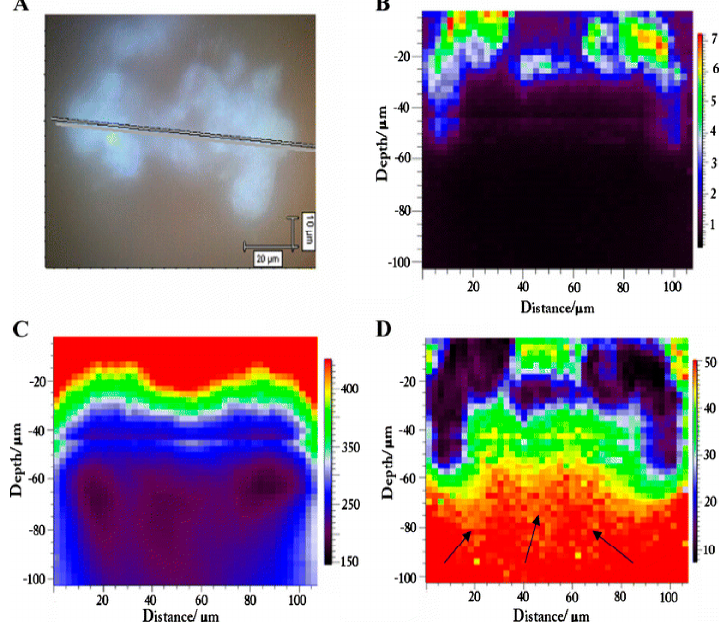
Figure 1. Colony in a pure small colony variant (SCV) PAO1 biofilm 21 days after inoculation, showing cavities filled with water and little biomass in the core of the colony. ( a ) Bright field image. Raman spectra (1084 cm − 1 ) were collected every 2.5 μ m in a plane extending down from the line shown through the colony in a. ( b ) Map of CH 3 signal (3300–3500 cm − 1 , biomass). ( c ) Map of OH signal (2905–2965 cm − 1 , water). ( d ) Map of water to biomass ratios (W/BRs). The arrows indicate the presence of streamers. The intensity scale for b and c (right-hand side of the figures) goes through blue to red as the peak area/1000 increases. The intensity scale for d goes through blue to red as the W/BR increases. Reproduced with permission from Springer [31].